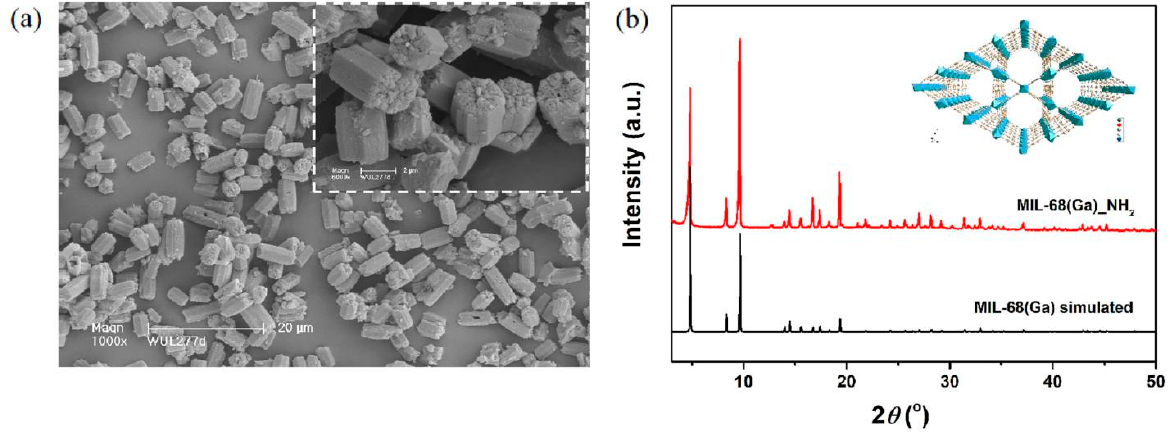
Figure 1. ( a ) SEM photograph of the as-synthesized MIL–68(Ga)_NH 2 ; the inset is SEM photograph at high resolution. ( b ) Simulated PXRD pattern of MIL–68(Ga), black; PXRD pattern of as-synthe- at high resolution. ( b ) Simulated PXRD pattern of MIL-68(Ga), black; PXRD pattern of as-synthesized sized sample of MIL–68(Ga)_NH 2 , red. sample of MIL-68(Ga)_NH 2 ,